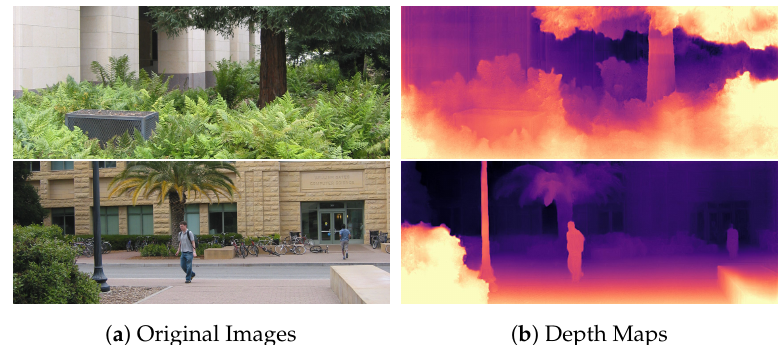
Figure 8. Qualitative results with